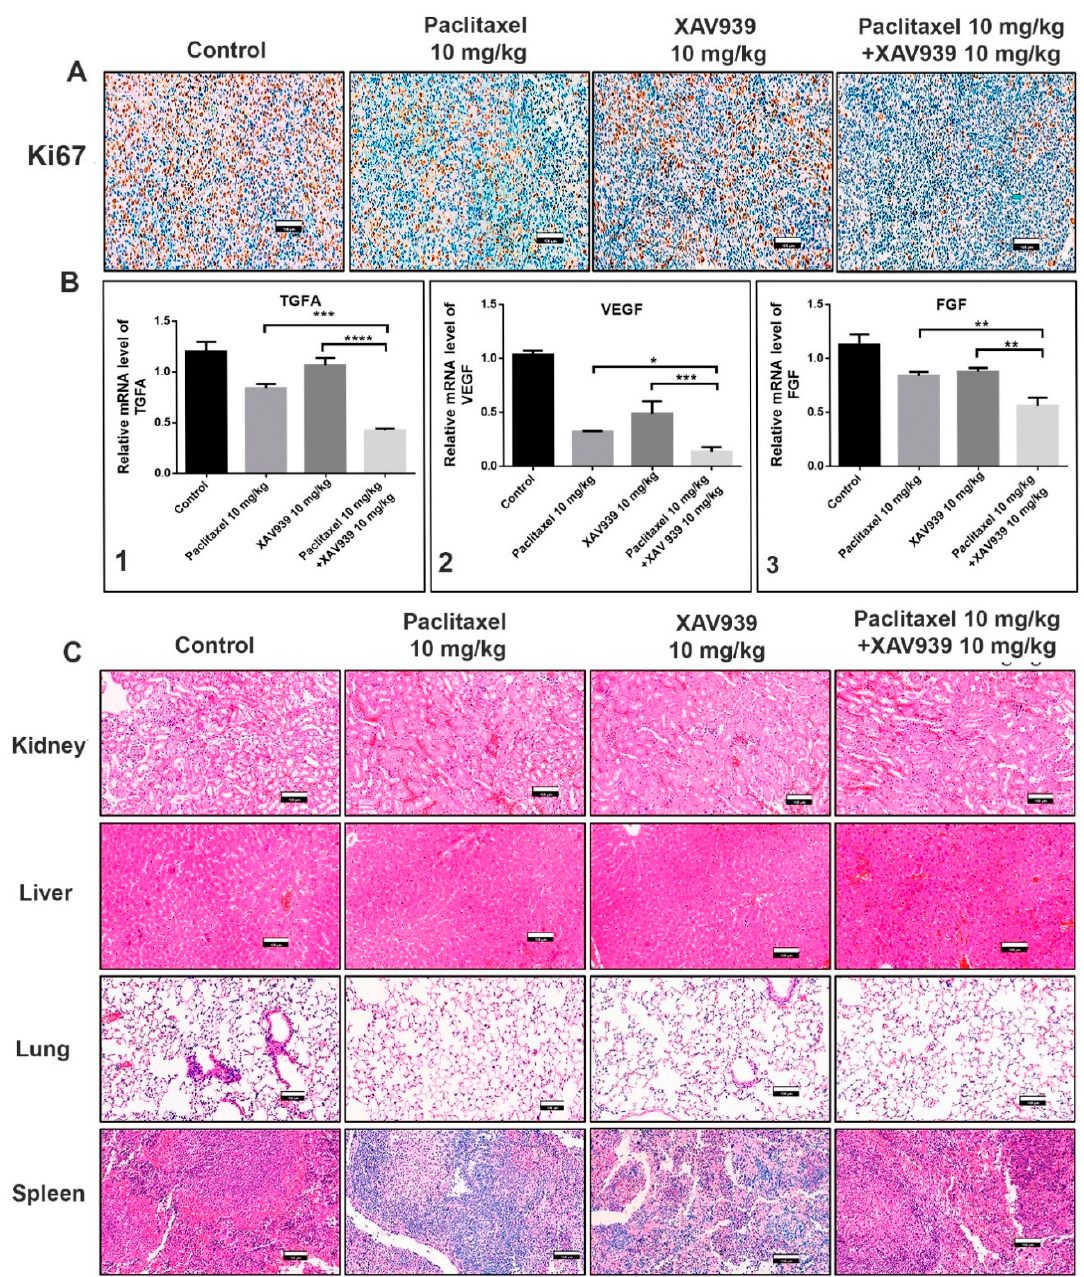
Figure 7. Combination regimen of paclitaxel and XAV939 suppressed cell proliferation and angiogenesis expression at protein and mRNA levels in MDA-MB-231-xenografted breast tumor models. ( A ) Tumor sections were subjected to immunohistochemistry (IHC) analysis for Ki-67 using anti-Ki-67 antibody and stained with DAB (a dark-brown color). The images represent the expression of Ki-67 in the control and the treatments with paclitaxel and / or XAV939. ( B ) The mRNA levels of ( B1 ) TGFA, ( B2 ) VEGF, and ( B3 ) FGF were analyzed by real-time RT-PCR. The relative expression of mRNA was normalized to the reference gene (GAPDH) and presented in a bar graph form. All data are expressed as mean ± SD (n = 3). *: p < 0.03, **: p < 0.005, ***: p < 0.001, and ****: p < 0.0001, compared to each single